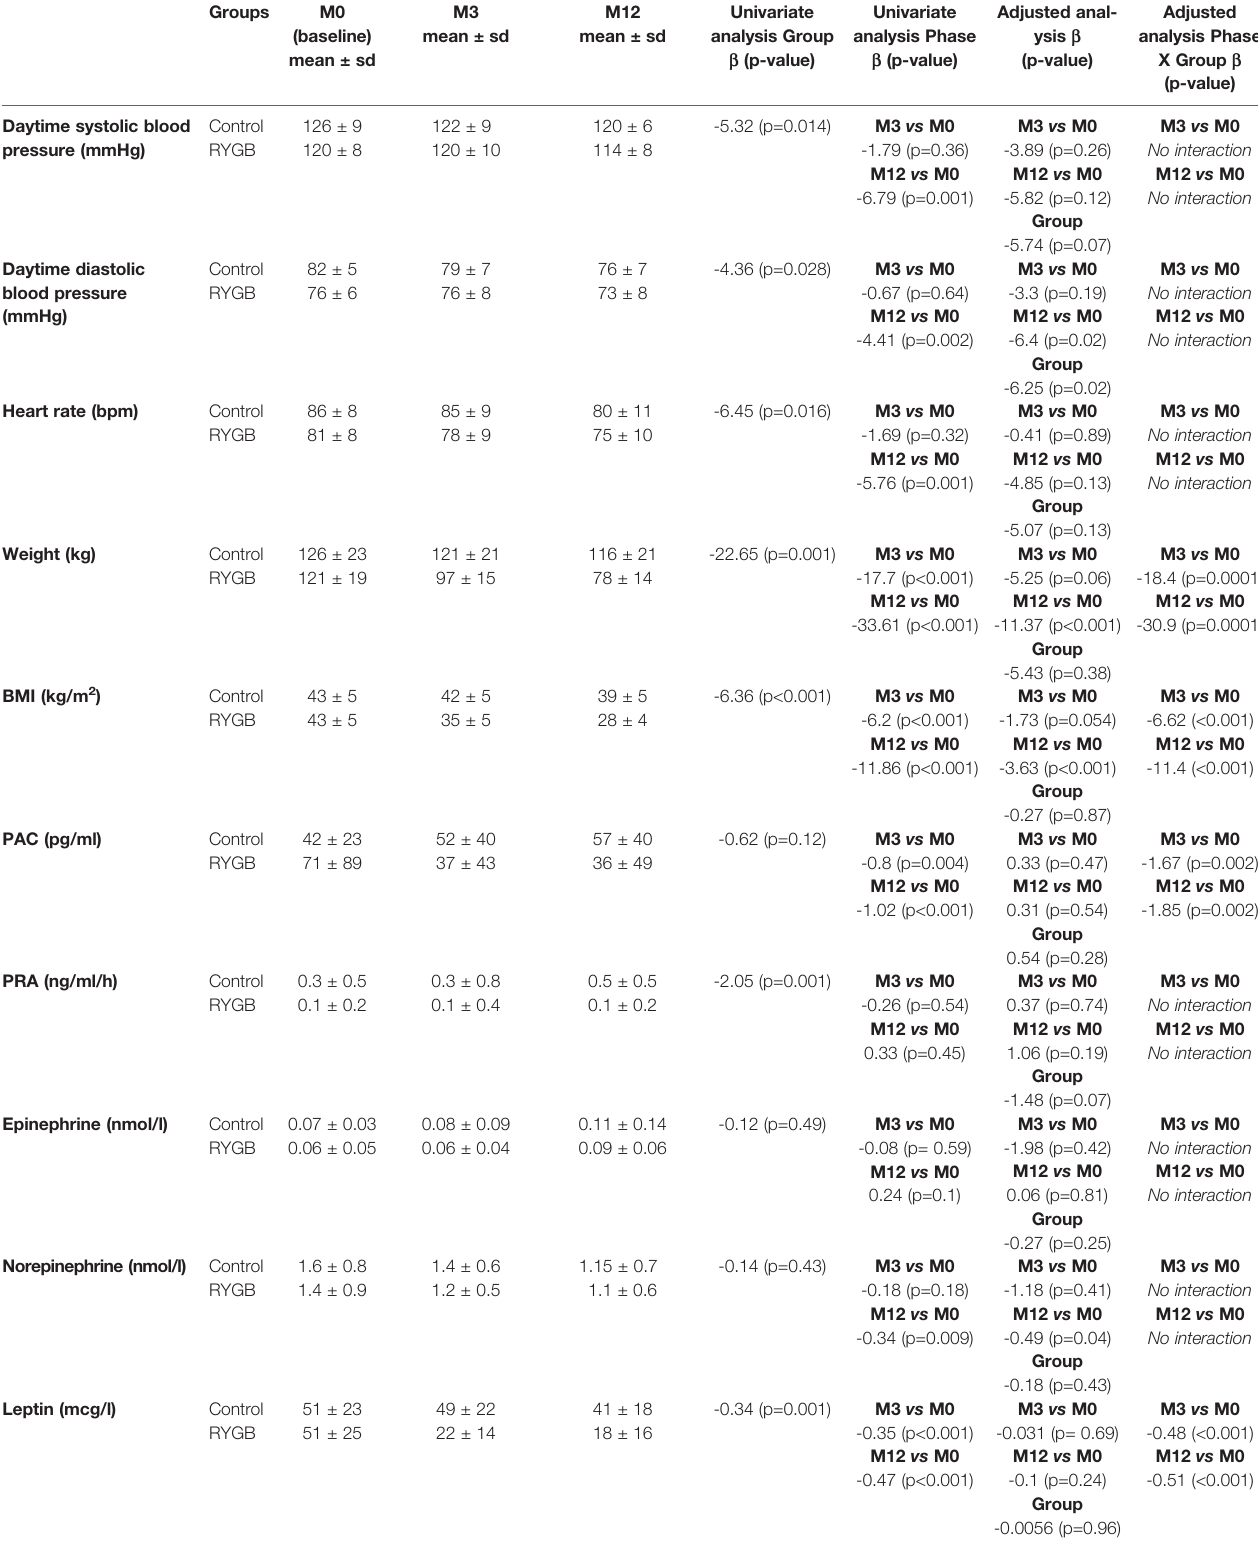
TABLE 2 | Changes in blood pressures, heart rate, weight, BMI, PRA, PAC, epinephrine, norepinephrine, and adipokines over